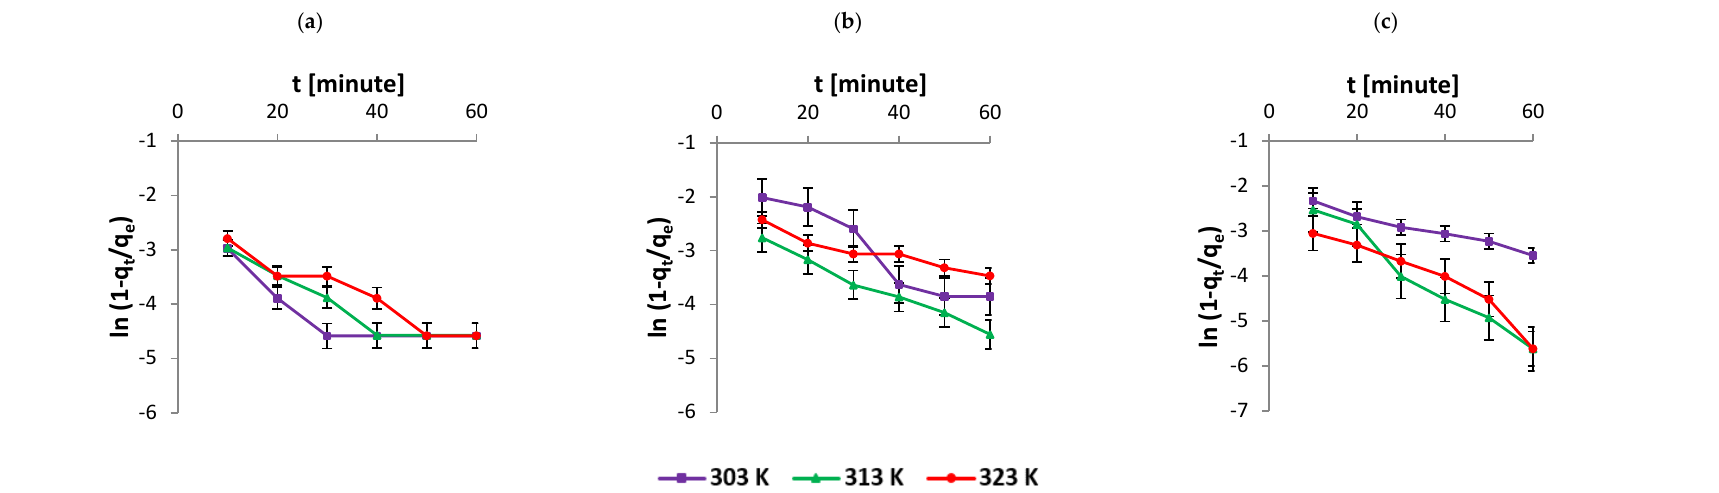
Figure 2. Kinetics data fitted to the film diffusion model with initial AR119 dye concentration ( a ) 100 µg mL −1 , ( b ) 200 µg mL −1 and ( c ) 300 µg mL −1 .